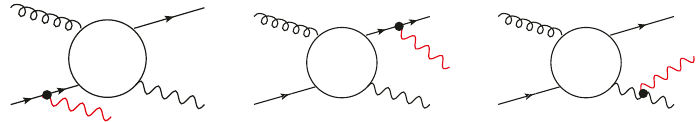
Figure 5 . Generic pp V V j topologies and kinematic regions that give rise to giant K -factors in ! the quark-gluon channel at NLO QCD. The blob denotes the hard scattering subprocess gq at the scale Q M W , while the subleading vector boson (red) is radiated by one of the SU(2) (cid:29) charged external states giving rise to EW logarithms of soft and collinear